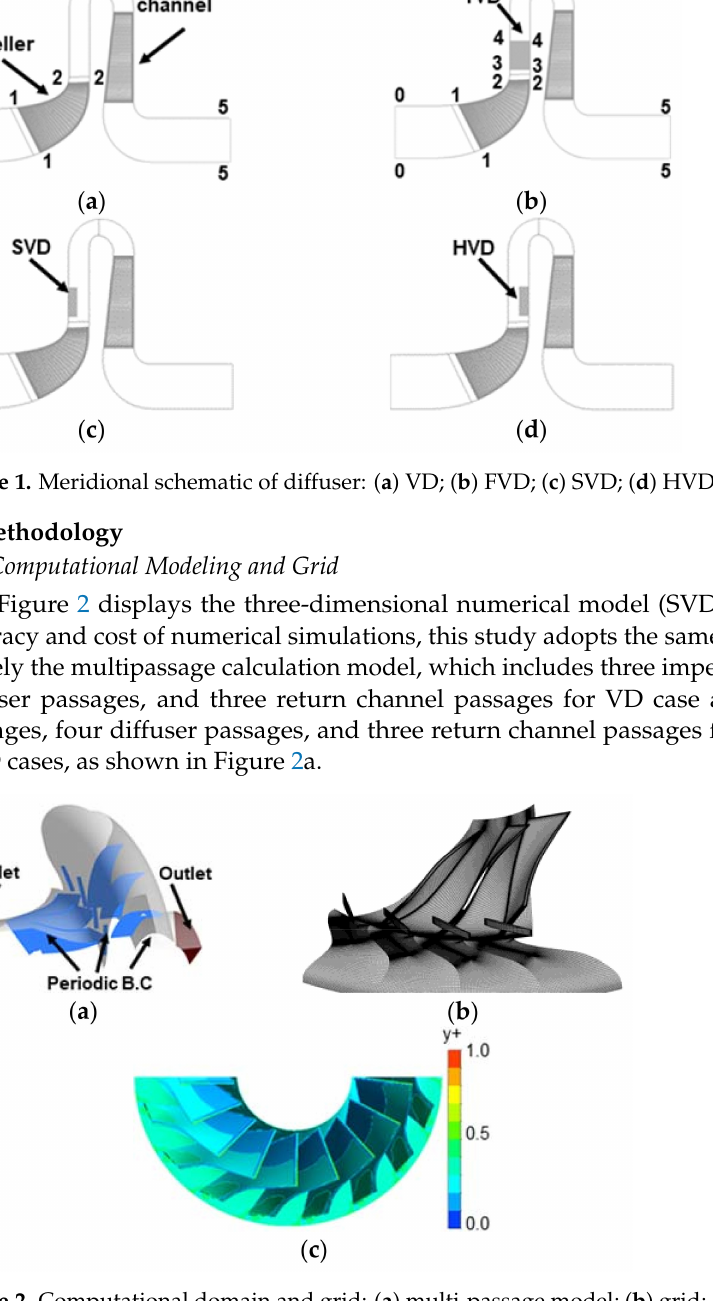
Figure 2. Computational domain and grid: ( a ) multi-passage model; ( b ) grid; ( c ) y